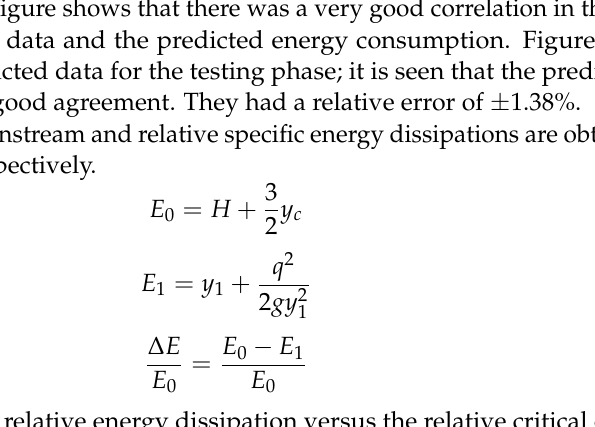
Figure 4. Variation of RMSE and R 2 vs. Gamma values for best model in the first scenario; ( a ) training, ( b ) testing.